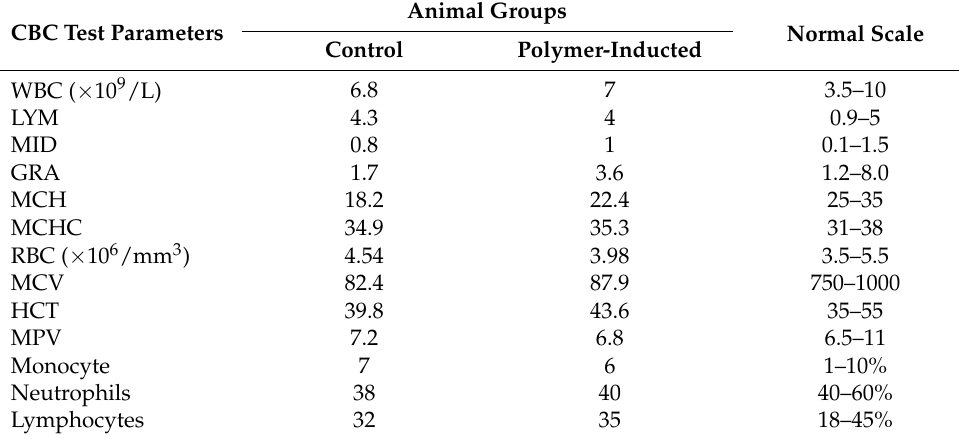
Table 1. Biochemical and hematological parameters of mouse blood after induction of Ocicum [21,22].